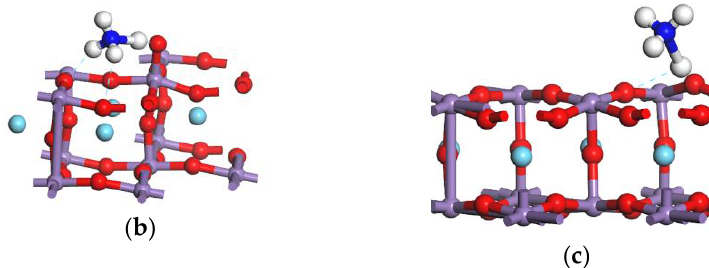
Figure 13. The configuration of NH 4+ on the LaMnO 3 surface. ( a ) on two active O ( b ) on one active O ( c ) on lattice O